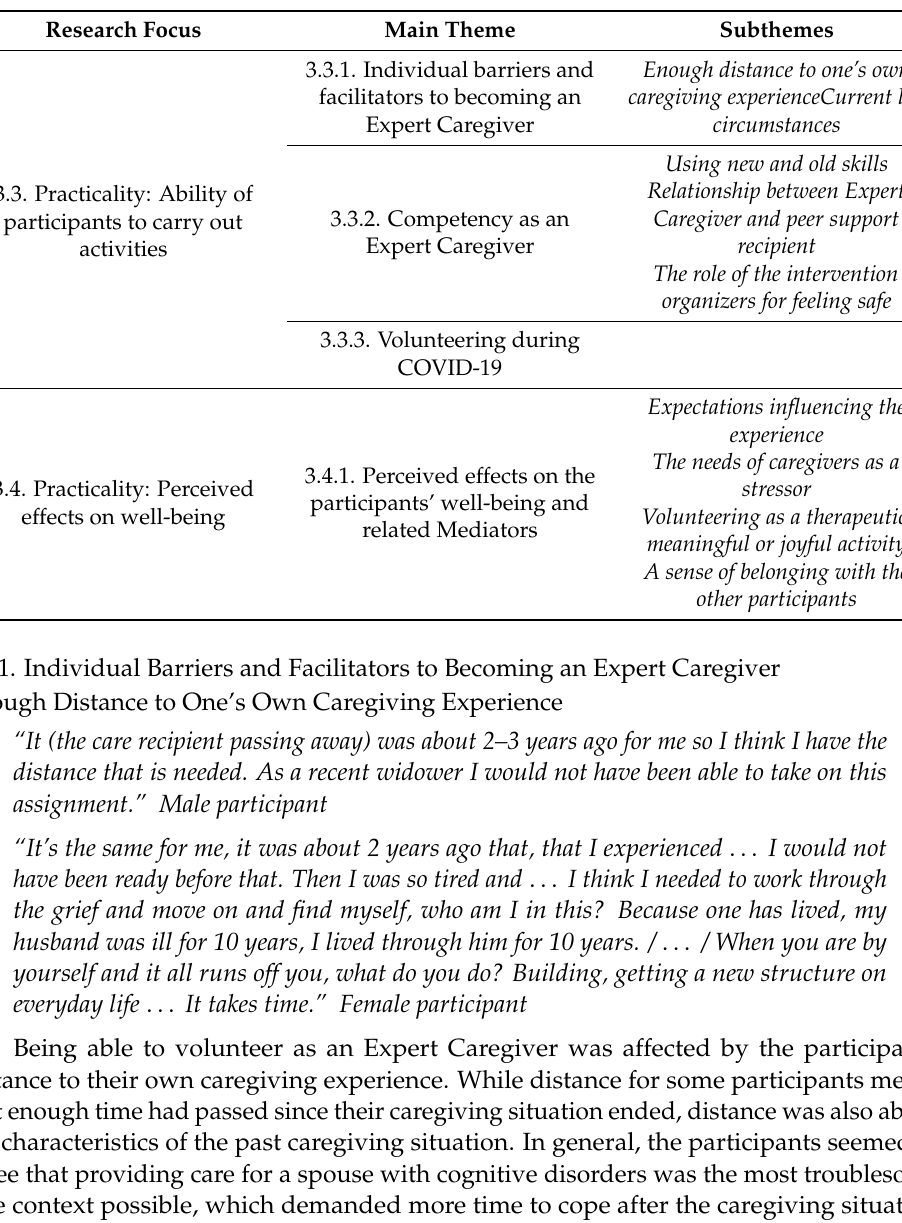
Table 3. Summary of results from the analysis of the focus group